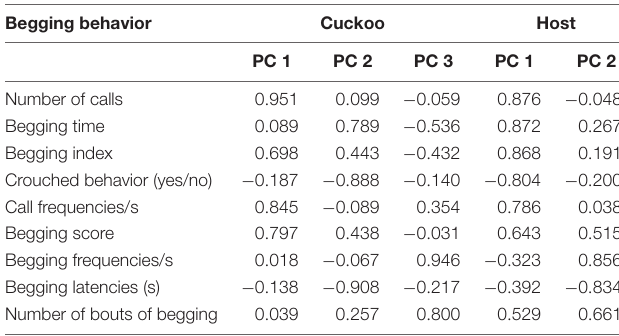
TABLE 1 | Component matrix of begging behavior in common cuckoo (cuckoo, n = 16) and oriental reed warbler (Host, n = 21) nestlings by PC analysis. Begging